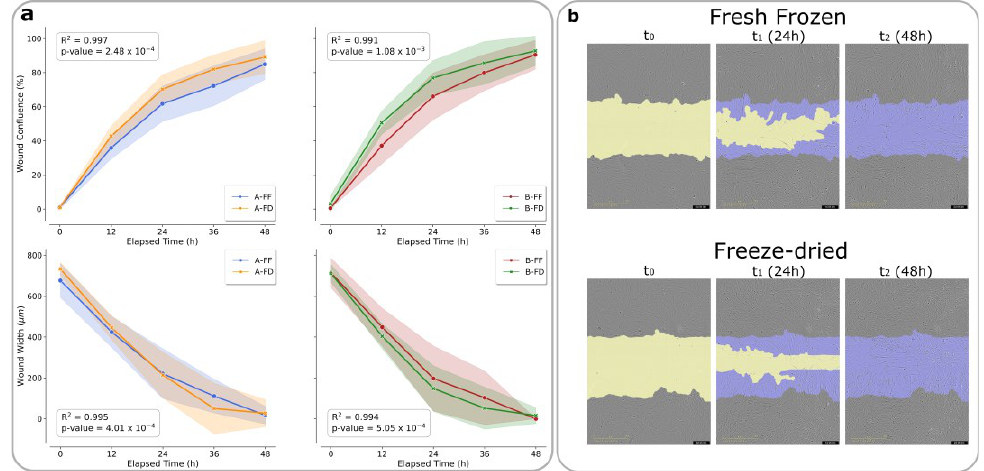
Figure 3. Analysis of the scratch wound on MIO-M1 treated with S-FF and S-FD. ( a ) Graphical representation of the wound confluence and wound width of MIO-M1 cells treated with 5% S-FF and S-FD preparations added to the growth medium; A = sample A, and B = sample B. ( b ) Representative images of MIO-M1 cells recorded using the IncuCyte S3 instrument with a 10x objective lens at different treatment times with S-FF and S-FD (t 0 = at the scratch, left column; t 1 = 24 h, middle column; t 2 = 48 h, right column). Yellow: initial scratch wound area; purple: MIO-M1 cells that migrated into the wound area.